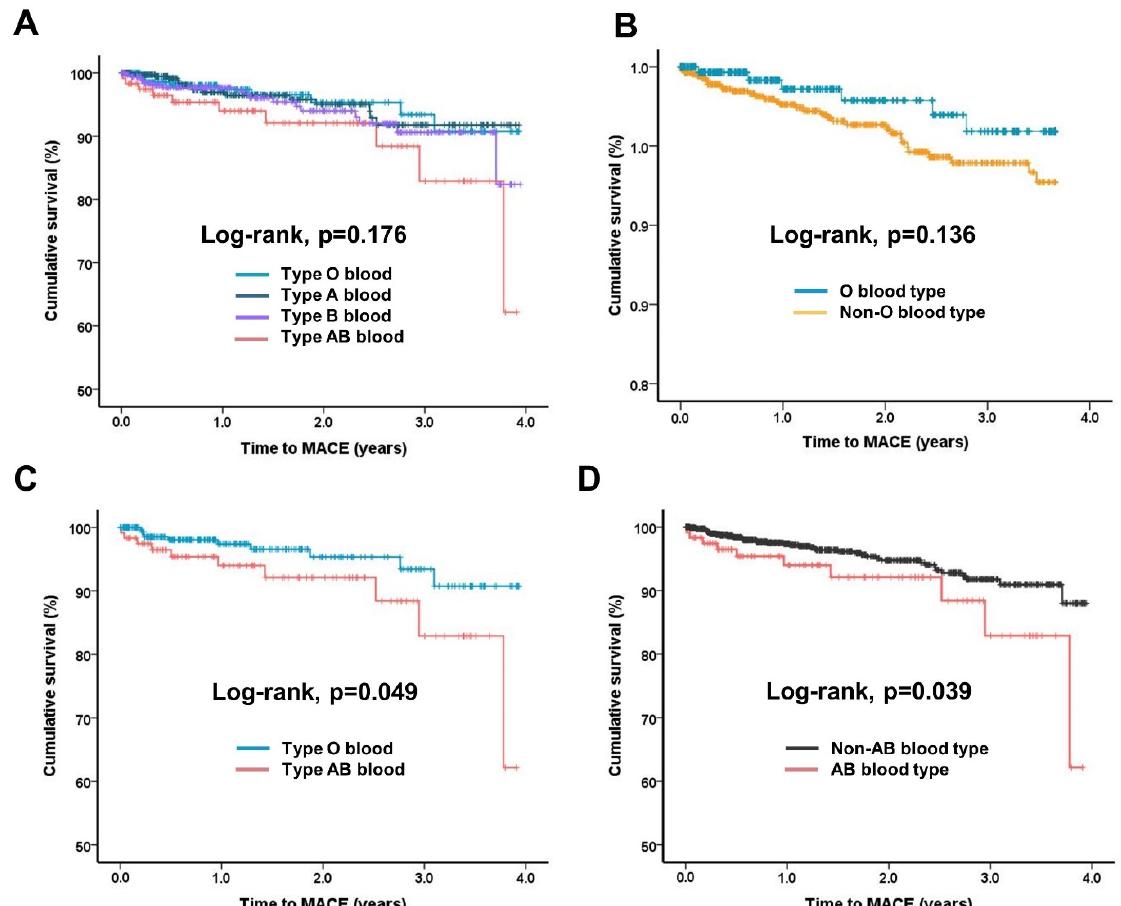
Figure 2. Kaplan–Meier survival analysis of different blood types. ( A ) All blood types; ( B ) O and non-O blood types; ( C ) O and AB blood types; ( D ) AB and non-AB blood types. MACE, major adverse cerebrovascular events.